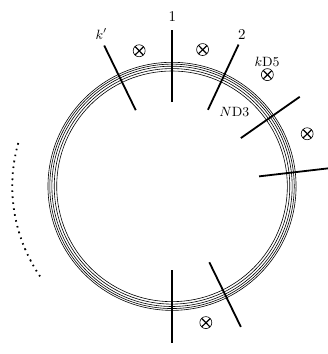
Figure 6 . Brane set-up underlying the AdS 4 (cid:2) S 2 (cid:2) S 2